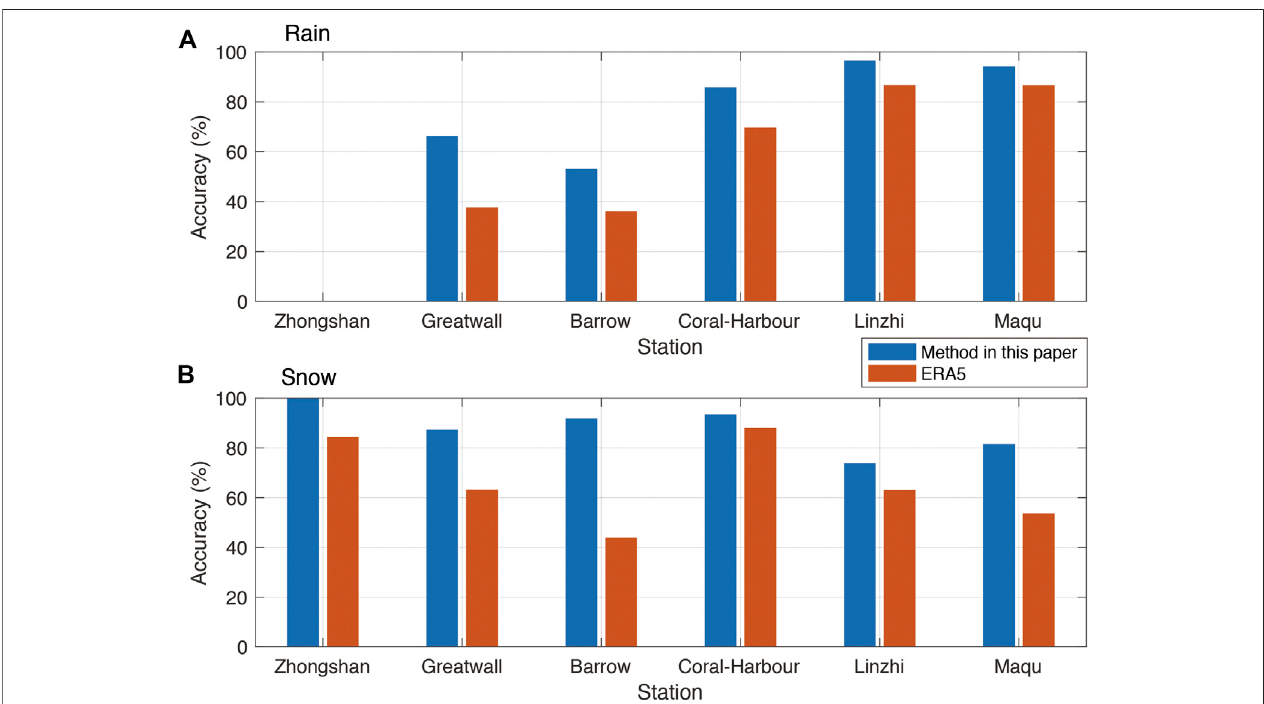
FIGURE 7 | Accuracy of precipitation type identi fi cation using the method in this paper and the ERA5 reanalysis datasets (sleet is excluded).